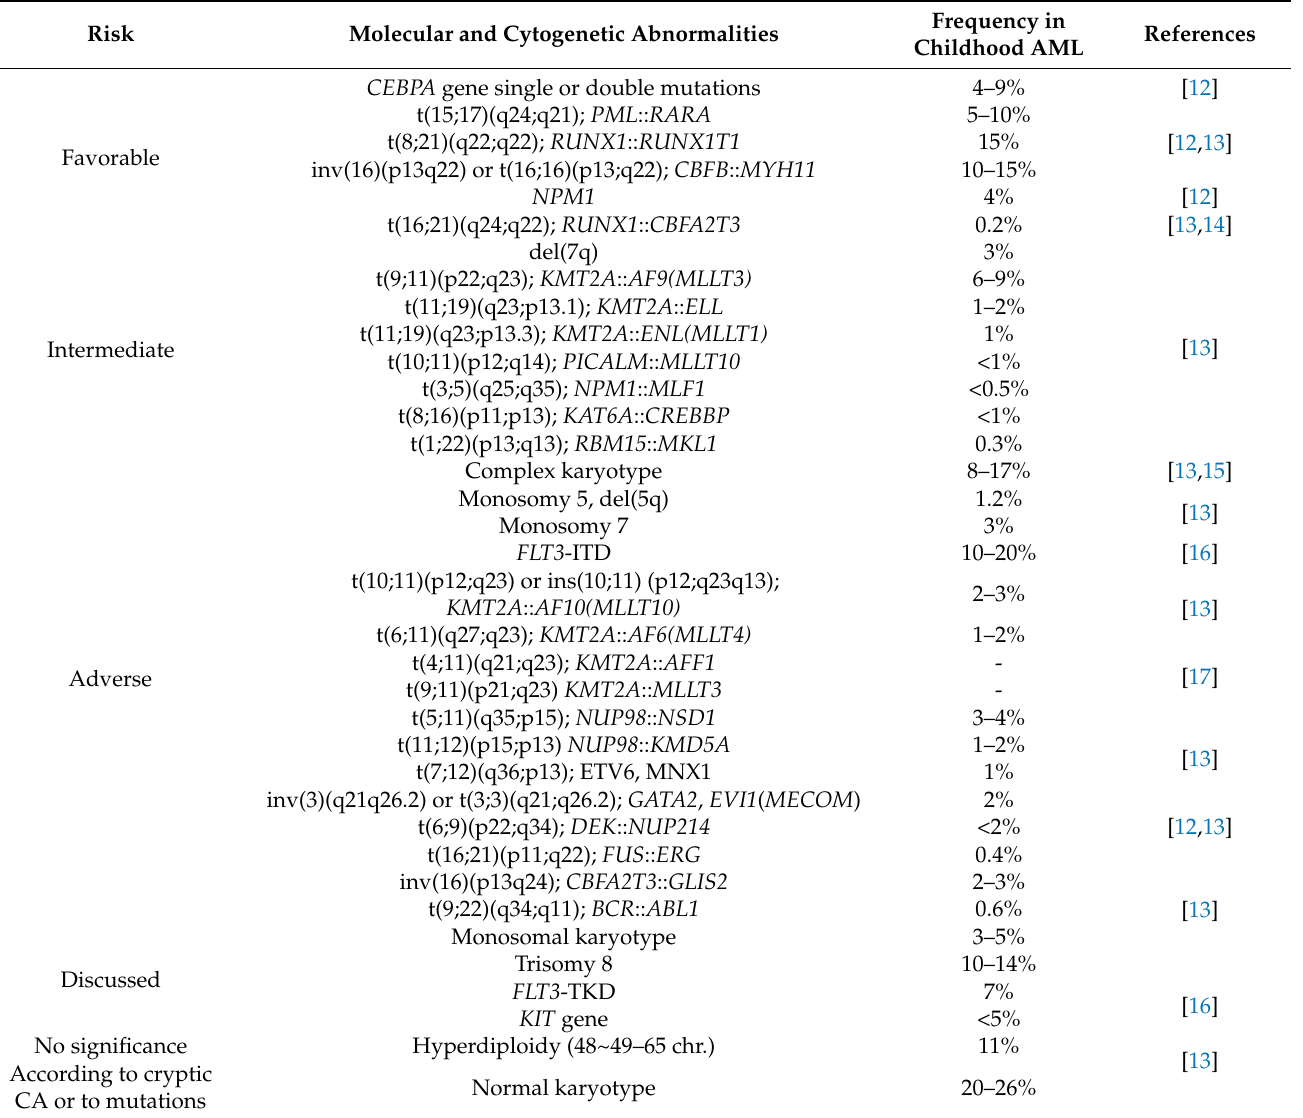
Table 1. Risk stratification based on molecular and cytogenetic abnormalities occurring in